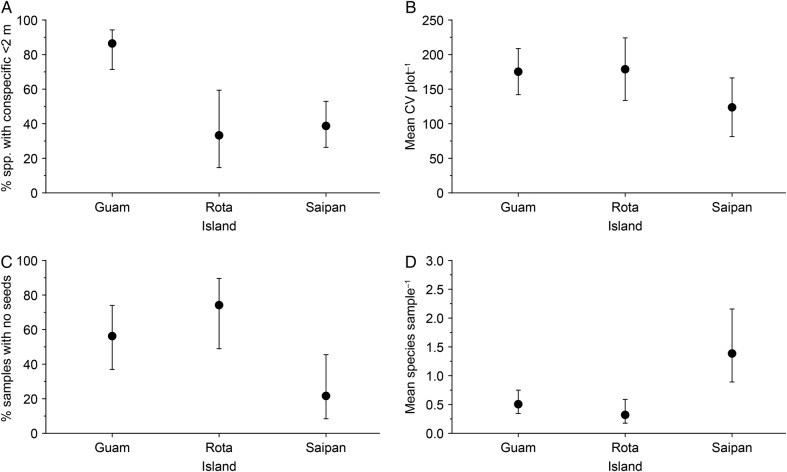
The per cent of species found in the seedbank at each plot that had an adult conspecific within 2 m on Guam where dispersers are functionally absent relative to Rota and Saipan where they are present (A), mean CV in seed density per seedbank sample at each plot (B), the per cent of seedbank samples that lacked any seeds (C) and the mean number of species per seedbank sample (D). Bars represent 95 % confidence intervals.